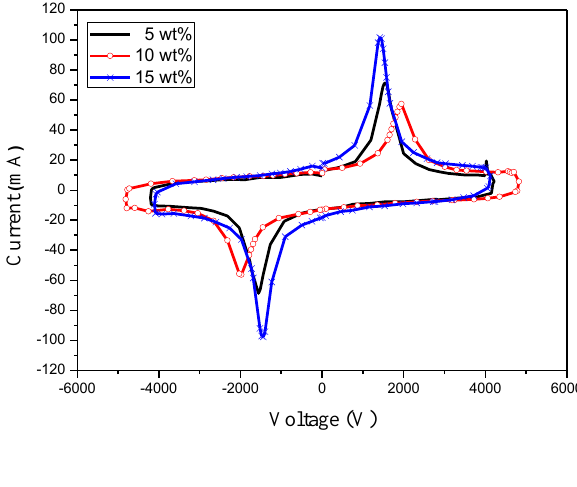
Figure 8. The C-V curves of PVDF films with different PVDF concentrations, which are annealed at 80 °C for 2